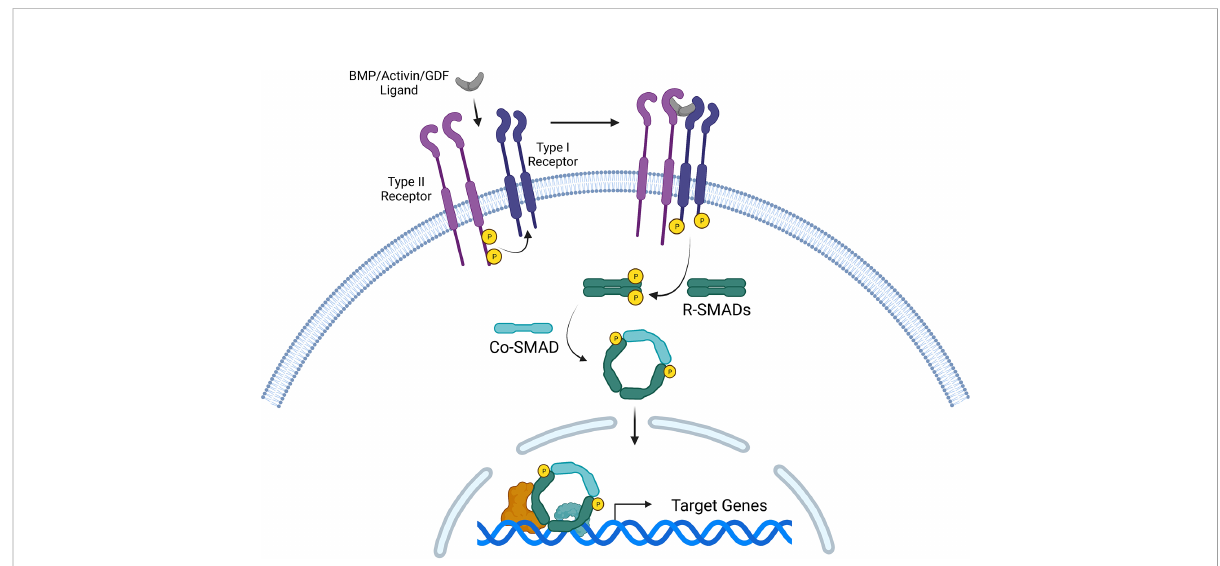
FIGURE 1 Canonical signaling pathway for three TGF- b superfamily members: bone morphogenetic proteins (BMPs), activins, and growth and differentiation factors (GDFs). Ligand binding induces the formation of a heteromeric receptor complex, resulting in constitutively active type II receptors transphosphorylating and activating type I receptors. The signal is transduced intracellularly via phosphorylated R-SMADs (such as R- SMAD1/5/8 or R-SMAD2/3). R-SMADs form complexes with Co-SMADs (such as SMAD4), which collectively serve as transcription factors that regulate target gene expression in the